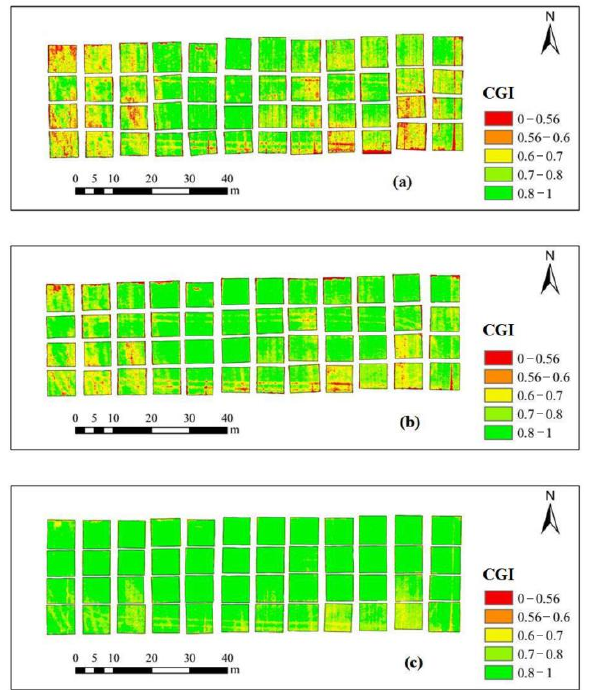
Figure 5. Map of CGI distribution based on UAV RGB imagery: ( a ) (GS 31); ( b ) (GS 47); ( c ) (GS 65).